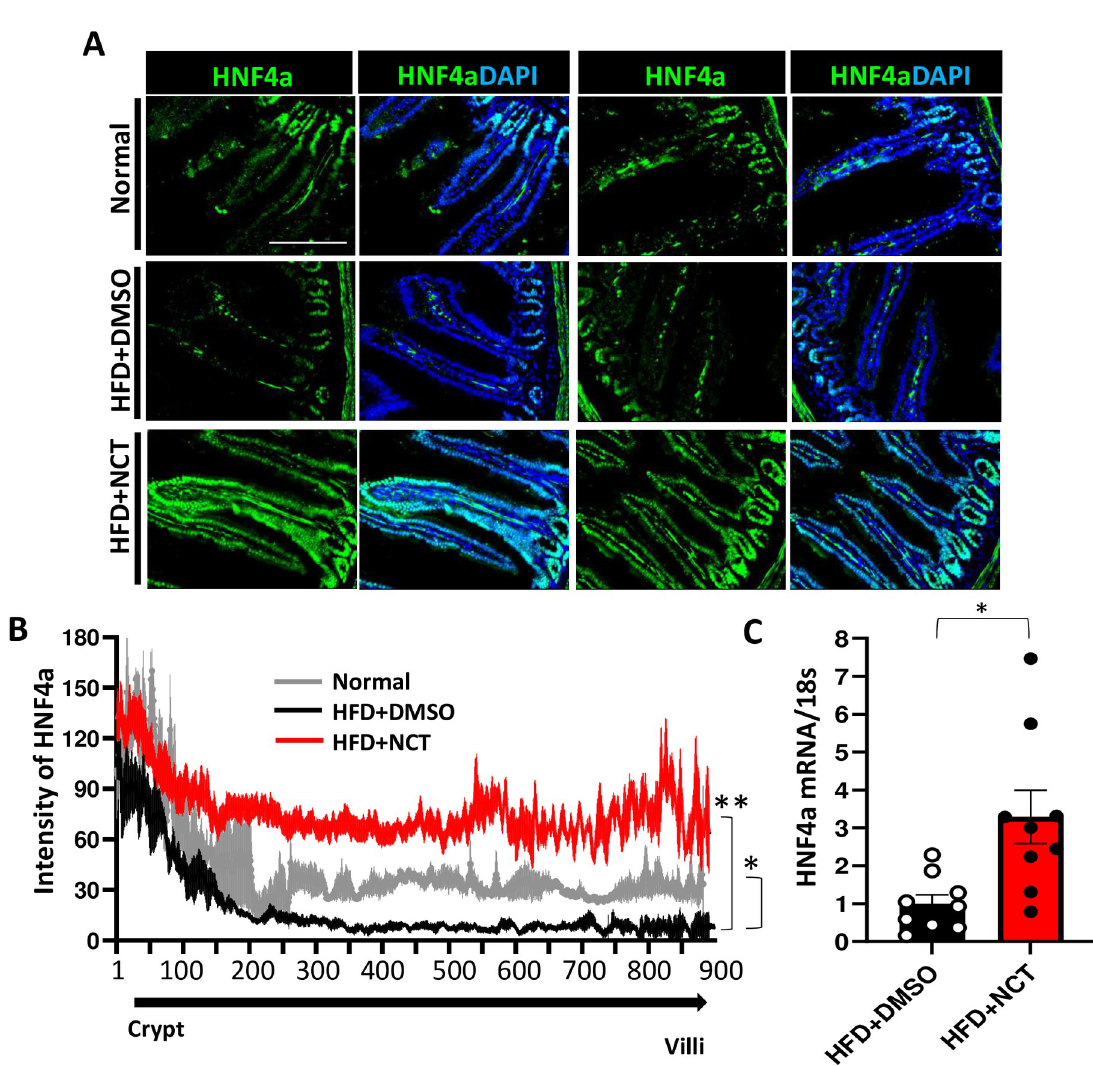
Fig 1. NCT induces HNF4 α expression in intestine. 14week old DIO mice (C57BL/6J) fed HFD were injected IP with NCT (200mg/kg bid) [29] or DMSO for two weeks, followed by harvesting of intestines. A . HNF4 α staining of a representative intestinal villus from intestine of each group. Frozen sections were stained with HNF4 α (green) and DAPI (blue) in mice fed normal diet, HFD+DMSO or HFD+NCT. B . Quantification of HNF4 α intensity along the length of the villus from crypt to villus tip in normal diet (gray), HFD +DMSO (black) and HFD+NCT (red) conditions. C . qPCR analysis of HNF4 α mRNA in mouse small intestine (N = 9) normalized with 18s rRNA. Values represent the mean ± SEM of 3–7 mice. � p < 0.05, �� p < 0.01 (HFD+DMSO vs Normal or HFD+NCT). Scale bar = 200 μ